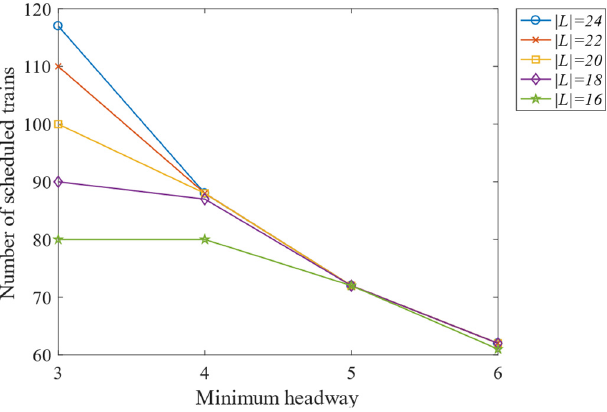
Figure 15. The variation of trains scheduled with the increase in the minimum headway.